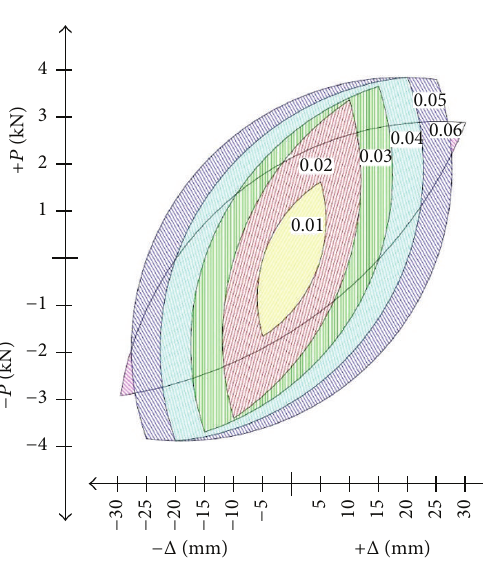
Figure 18: Calculation of energy dissipated by saddlebag connec-